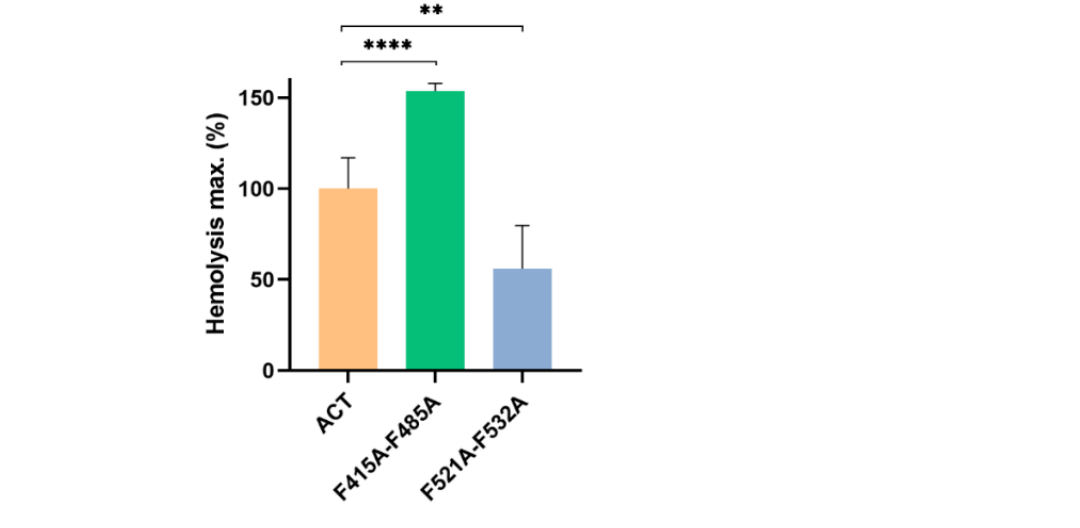
Figure 8. Effect of double Ala substitutions in the central Phe residues of the potential cholesterol- binding sites F415A-F485A and F521A-F532A on the maximum haemolytic percentage. Haemolysis induced by 50 nM of intact ACT or by each one of the mutant toxins was assayed with a suspen- sion of sheep erythrocytes (5 × 10 8 cells/mL) incubated with each protein for 180 min at 37 ◦ C. Data represented in the figure correspond to the mean of three independent experiments ± SE. The one-way ANOVA (Brown–Forsythe test) with Dunnett multiple comparisons test was used to determine whether there is a significant difference between the mean values of our independent groups (** if p ≤ 0.01 and **** if p ≤